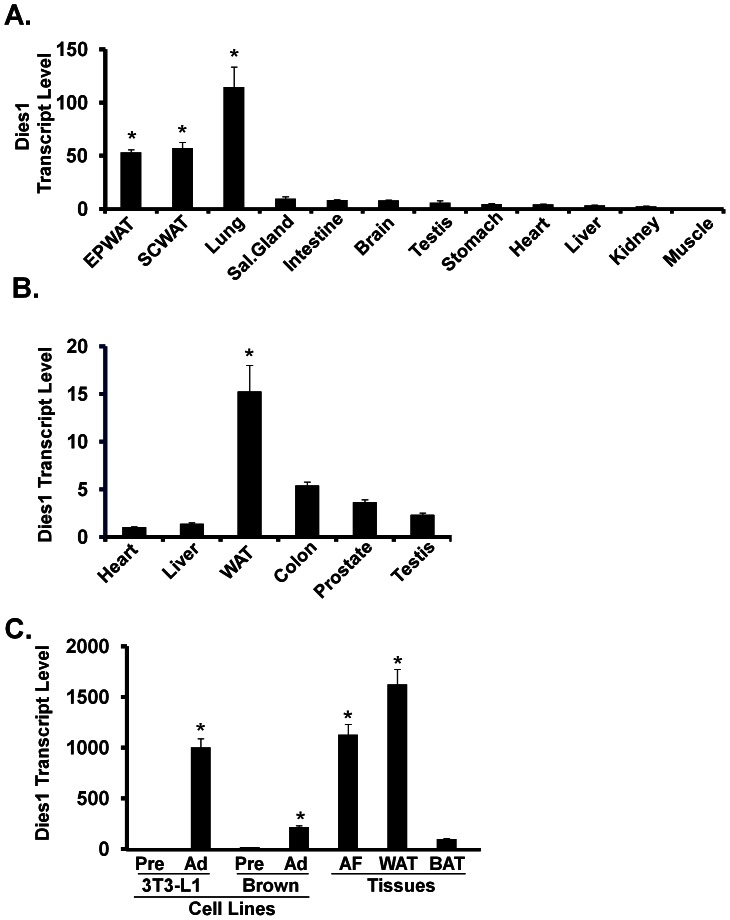
Expression of Dies1 Transcript in Tissues.
A. Murine Tissues. qPCR analysis of Dies1 transcript level in a panel of 12 murine tissues. Value of muscle was set to 1. For first three columns, * indicates p<0.05 compared to all other columns. * indicates p<0.05 compared to all other columns. B. Human Tissues
. qPCR analysis of Dies1 transcript level in a panel of 6 human tissues. Value of heart was set to 1. * indicates p<0.05 compared to the columns lacking an asterisk. C. Adipocytes and Adipose Tissues. qPCR for relative levels of Dies1 transcript in 3T3-L1 or WT-BAT preadipocytes (Pre) or adipocytes (Ad), the purified adipocyte fraction of murine WAT (AF), or intact murine WAT and BAT. Human samples were in monoplicate, murine samples in duplicate; qPCR was conducted in triplicate wells. For each column notated with an* this indicates p<0.05 compared to the columns lacking an asterisk.